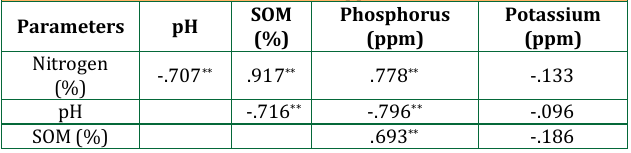
Table 10: Soil pH and SOM with different soil nutrient parameters in different altitude of apple